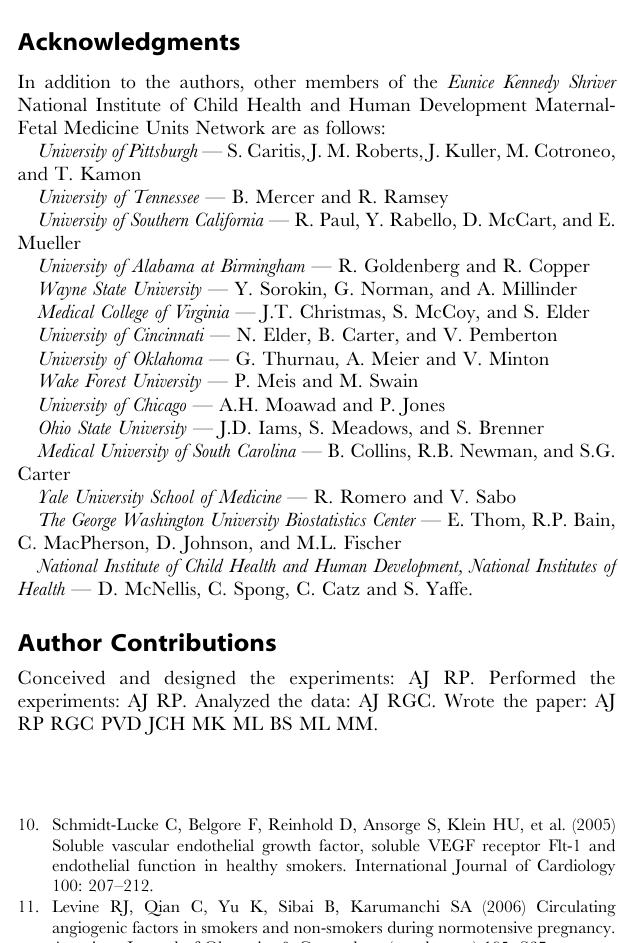
Rate of preeclampsia Rate of preeclampsia among smokers, n (%) among nonsmokers, n (%) Odds ratio (95%